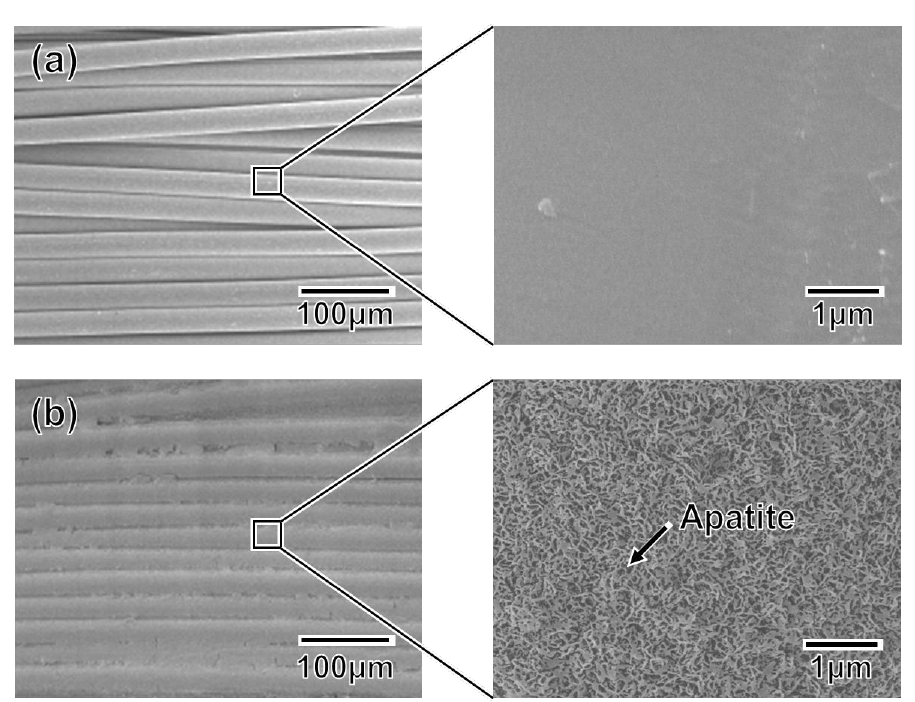
Figure 9. SEM images collected at varying magnifications from ( a ) the untreated mesh specimen and ( b ) the P100 mesh specimen after a 24 h immersion in